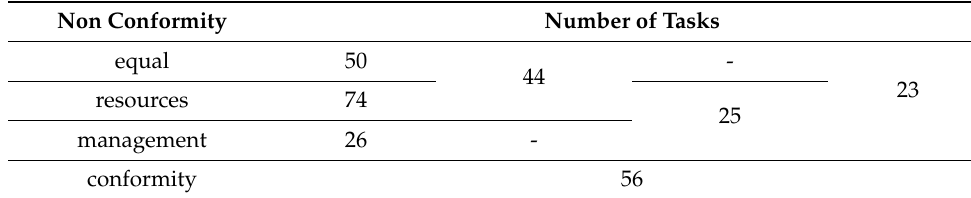
Table 3. Assessment of conformity with